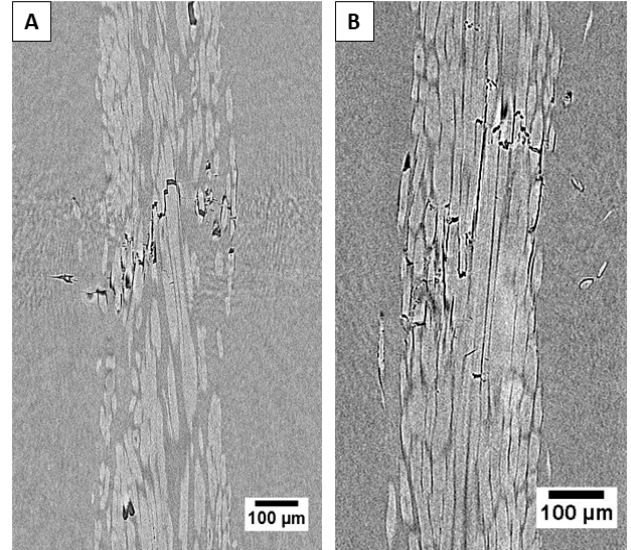
Figure 9. Representative debonding length observation by micro computed tomography. High resolution micro-CT images for the Peclyve 10 wt % / 6 h treated flax / epoxy ( A ) and flax / vinylester ( B ) single yarn samples.